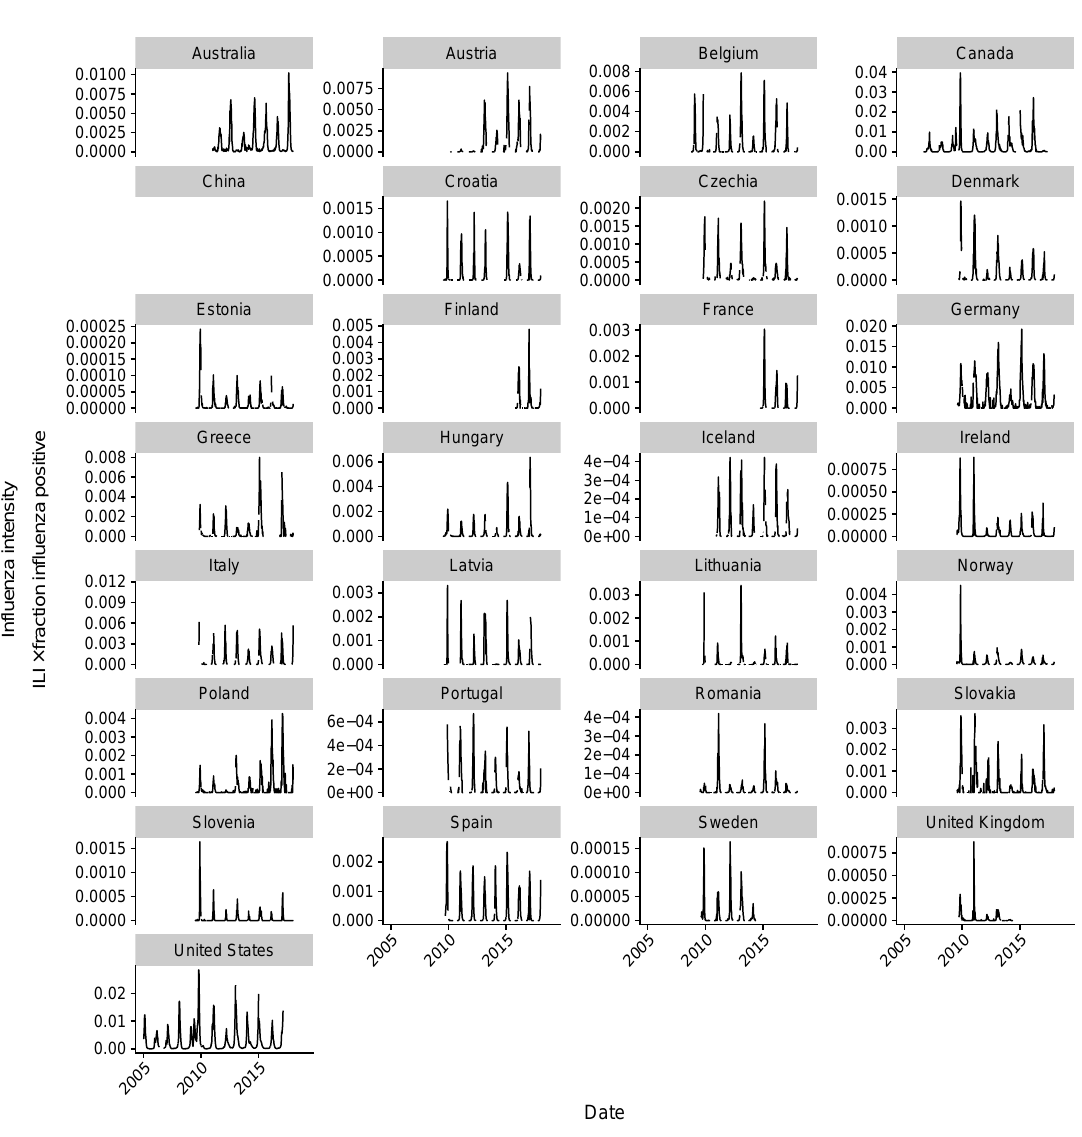
Figure A9. Influenza intensity (ILI × fraction of influenza positive respiratory samples [57]) is shown by country at weekly resolution. For China, the influenza intensity is simply the fraction of influenza positive respiratory samples, since ILI (or any other measure of respiratory illness incidence) is not reported. A fixed y -axis scale is shown in Figure